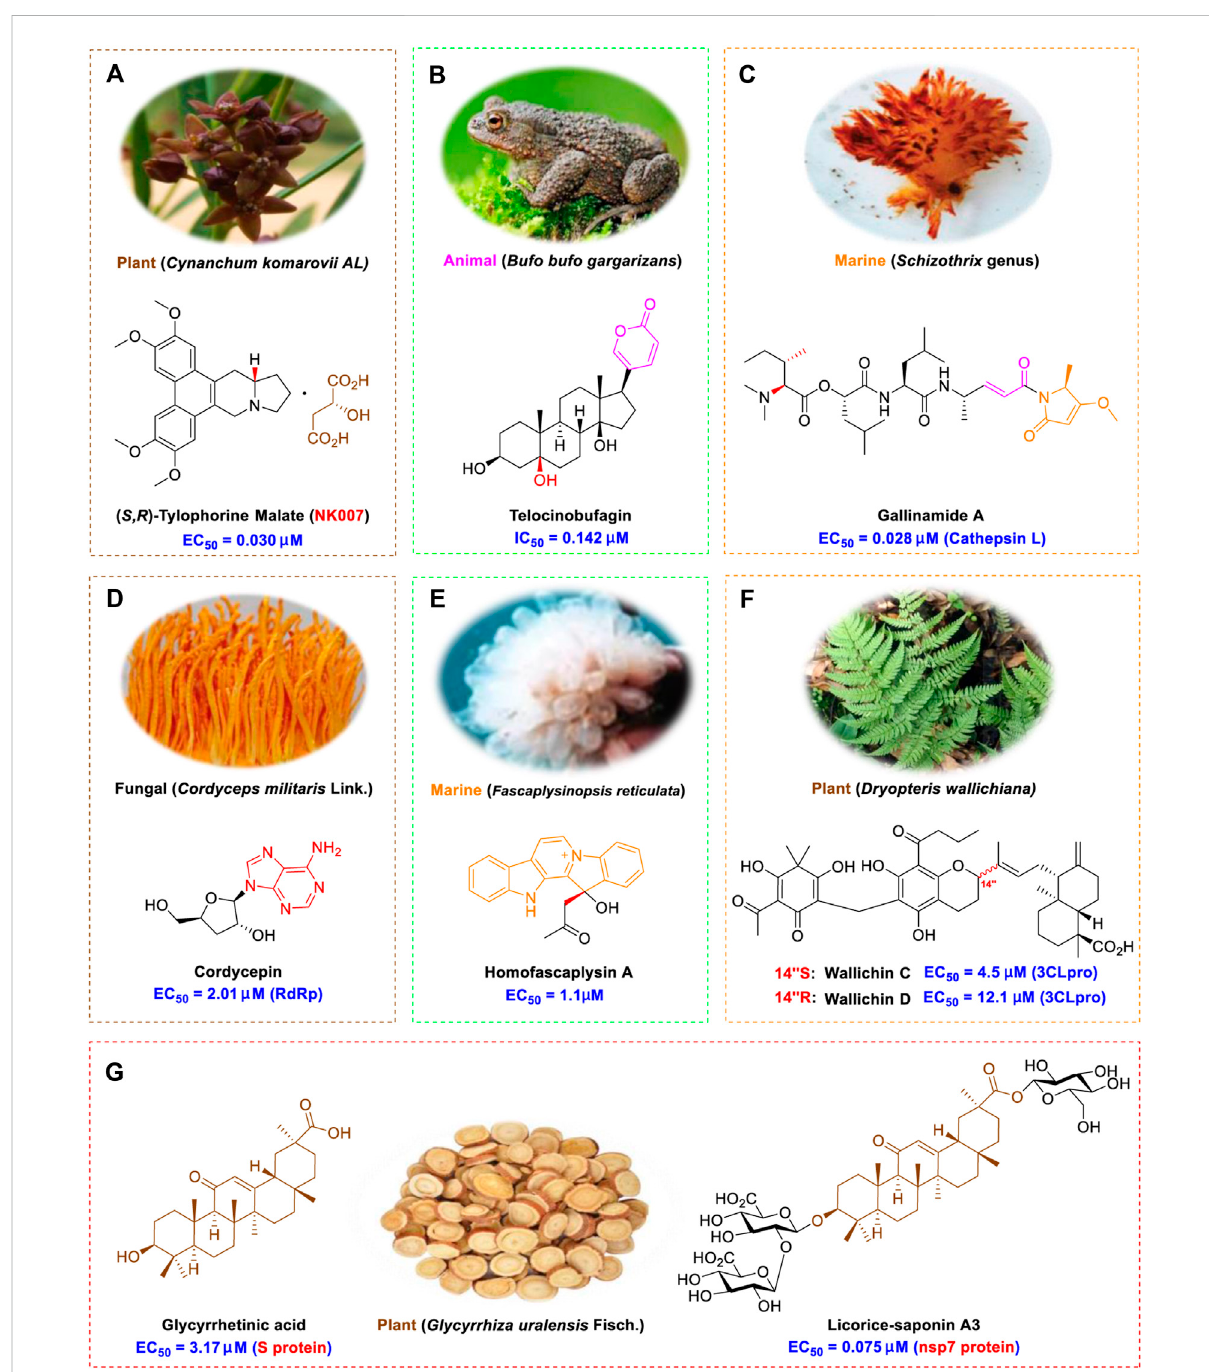
FIGURE 1 Promising natural products in COVID-19 therapy. (A) Tylophorine can be isolated from the medicinal plant Cynanchum komarovii AL. (B) Telocinobufagin can be isolated from the traditional medicinal animal toad Bufo gargarizans . (C) Gallinamide A can be isolated from the marine cyanobacteria Schizothrix genus. (D) Cordycepin can be isolated from the traditional medicine Cordyceps militaris Link. (E) Homofascaplysin A can be isolated from the marine sponge Fascaplysinopsis reticulata . (F) Wallichins C and D can be isolated from the medicinal fern Dryopteris wallichiana . (G) Licorice-saponin A3 and glycyrrhetinic acid can be isolated from the medicinal plant Glycyrrhiza uralensis